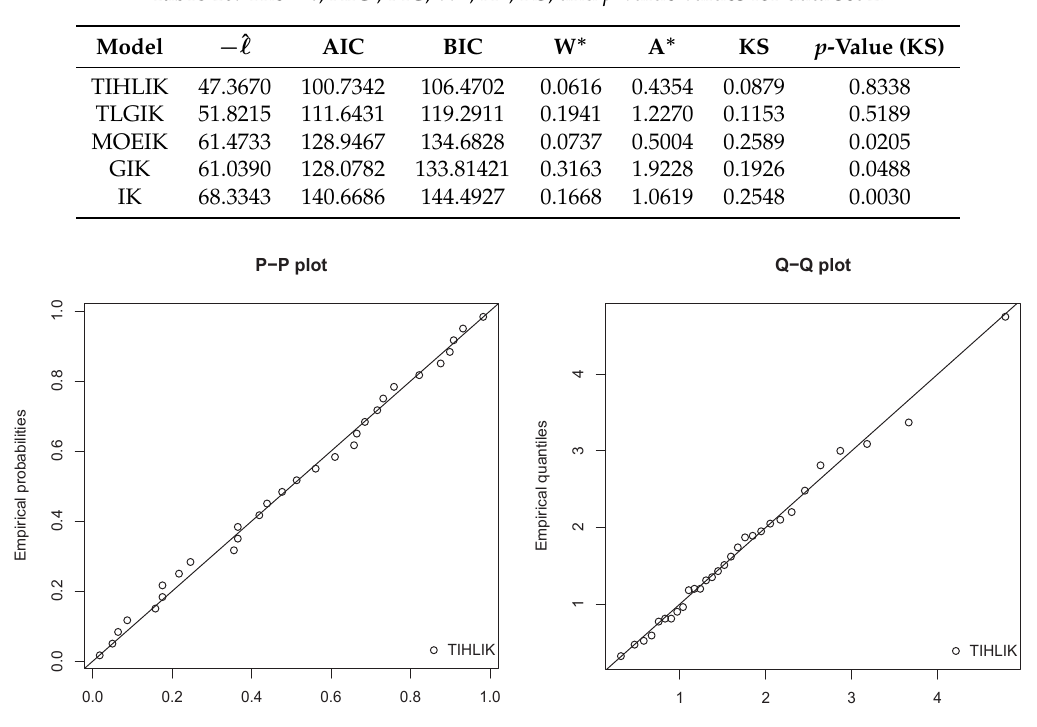
Figure 11. Probability–Probability (P–P) plots and Quantile–Quantile (Q–Q) plot of the estimated TIHLIK model for data set 1.